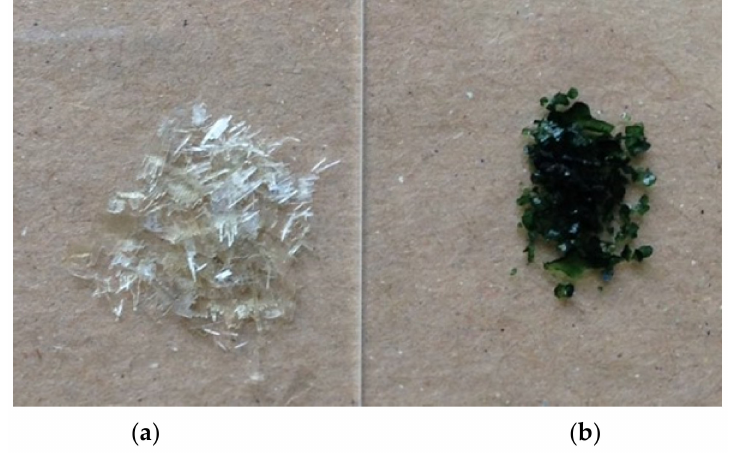
Figure 1. Photograph of crystalline samples of 1 . ( a ) Colorless plates; ( b ) plates coated with green amorphous material, as text describes.